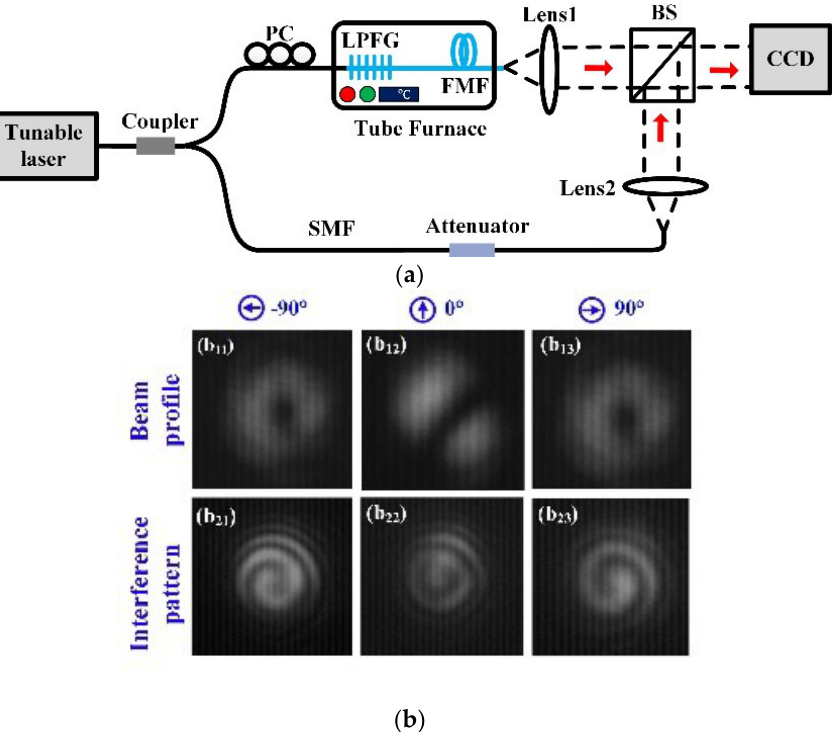
Figure 4. ( a ) Experimental configuration used to detect orbital angular momentum (OAM) modes generated by the CO 2 -laser-induced LPFG; ( b ) (b 11 –b 13 ) An experimentally generated vector mode with phase delays of +π/2, 0, and −π/2 and test results are using the same sample with a grating pitch of 1200 µm at 1588.1 nm. (b 21 –b 23 ) OAM interference patterns with topological charges of l = +1, l = 0, and l = −1, respectively.